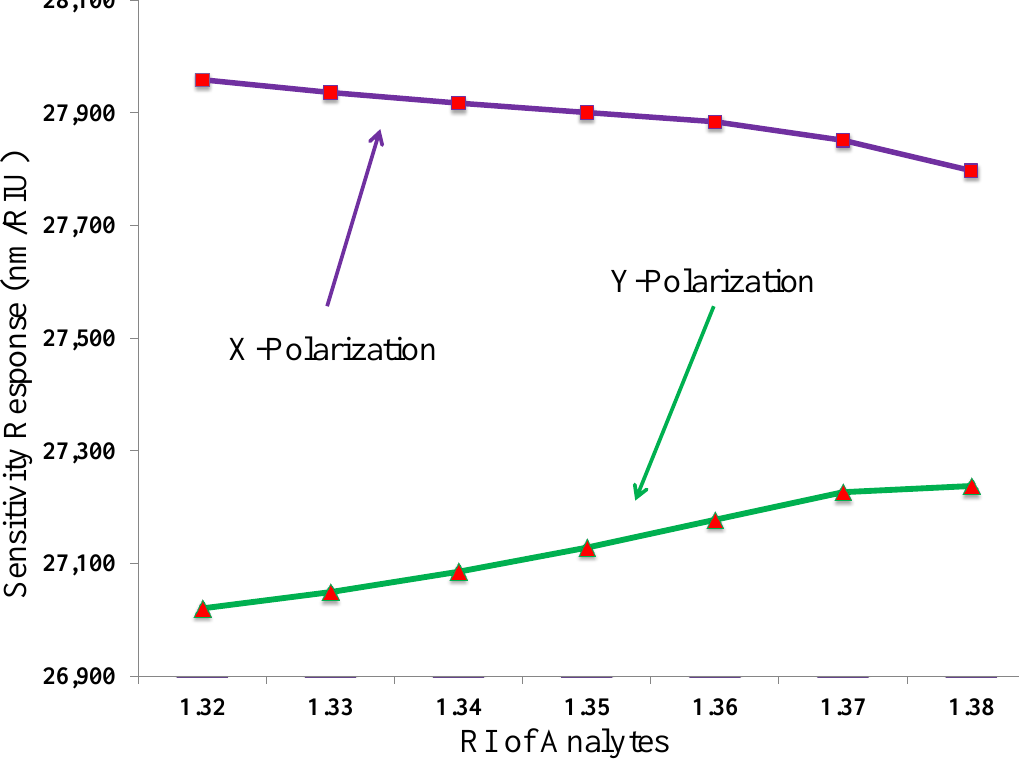
Figure 8. The sensitivity response with respect to RI of analytes for X- and